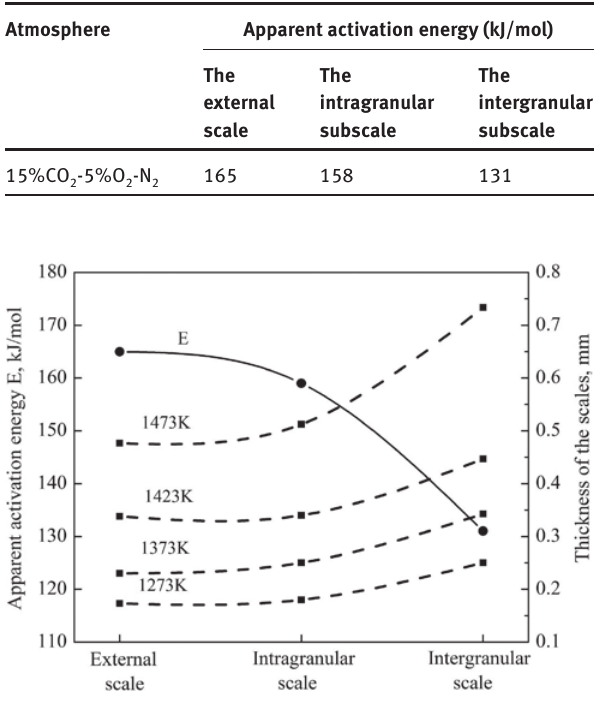
Fig. 12: Relationships between apparent activation energy and the thickness of the scales